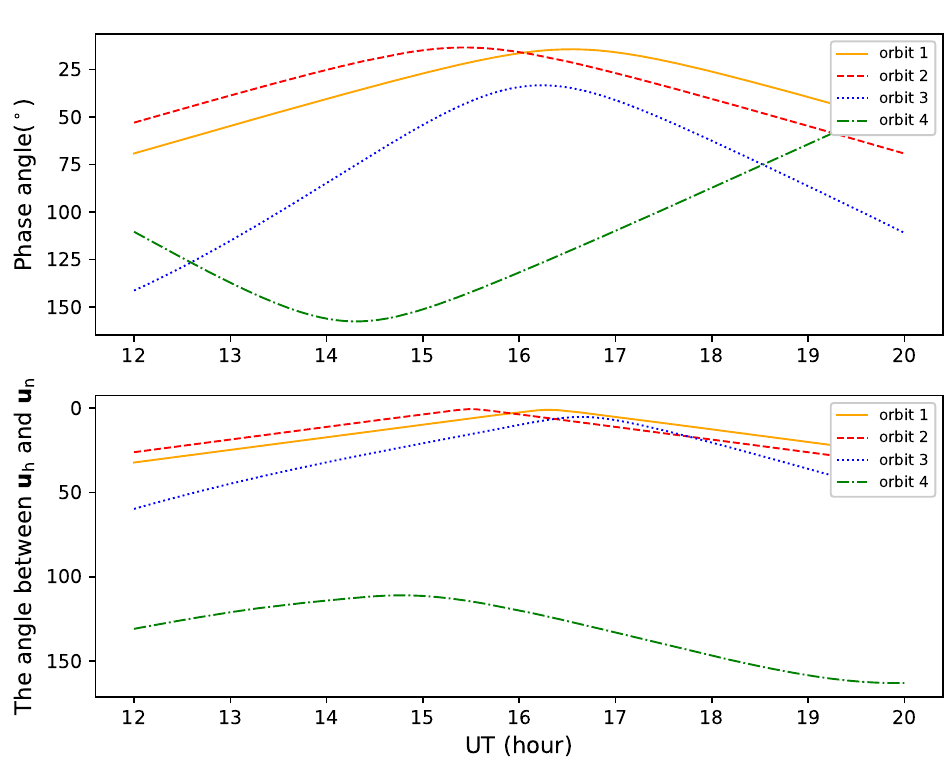
Figure 3. The variation of the angles with time for different